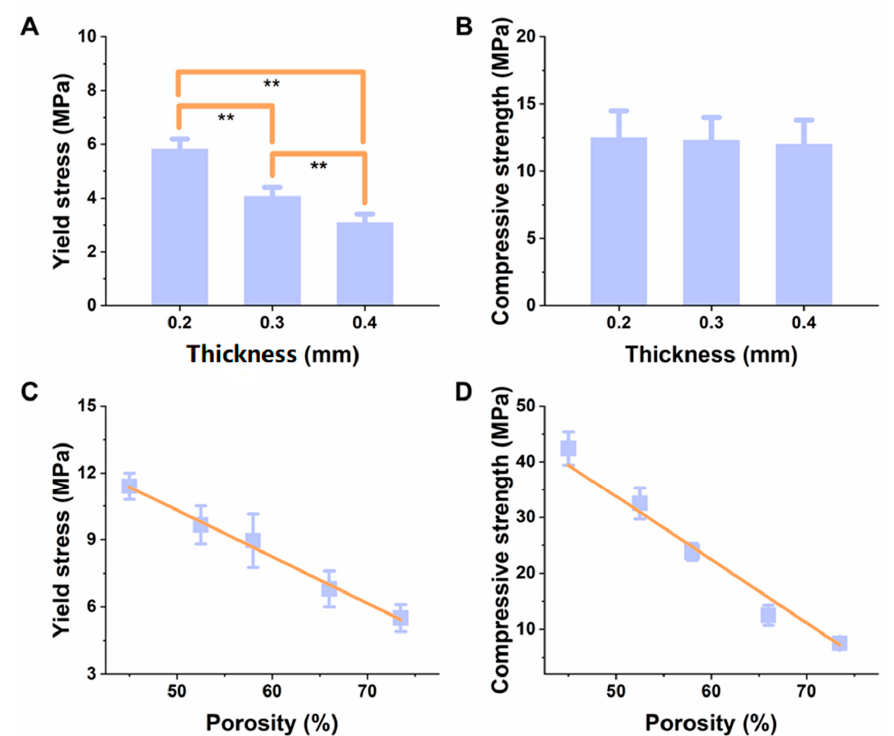
Figure 2. Change of ( A ) yield stress, and ( B ) compressive strength at a varied thickness (0.2, 0.3, and 0.4 mm) and porosity (45%, 52%, 59%, 66%, and 73%), ( n = 5). Change of ( C ) yield stress, and ( D ) compressive strength at a varied porosity (45%, 52%, 59%, 66%, and 73%),** represents p < 0.01.